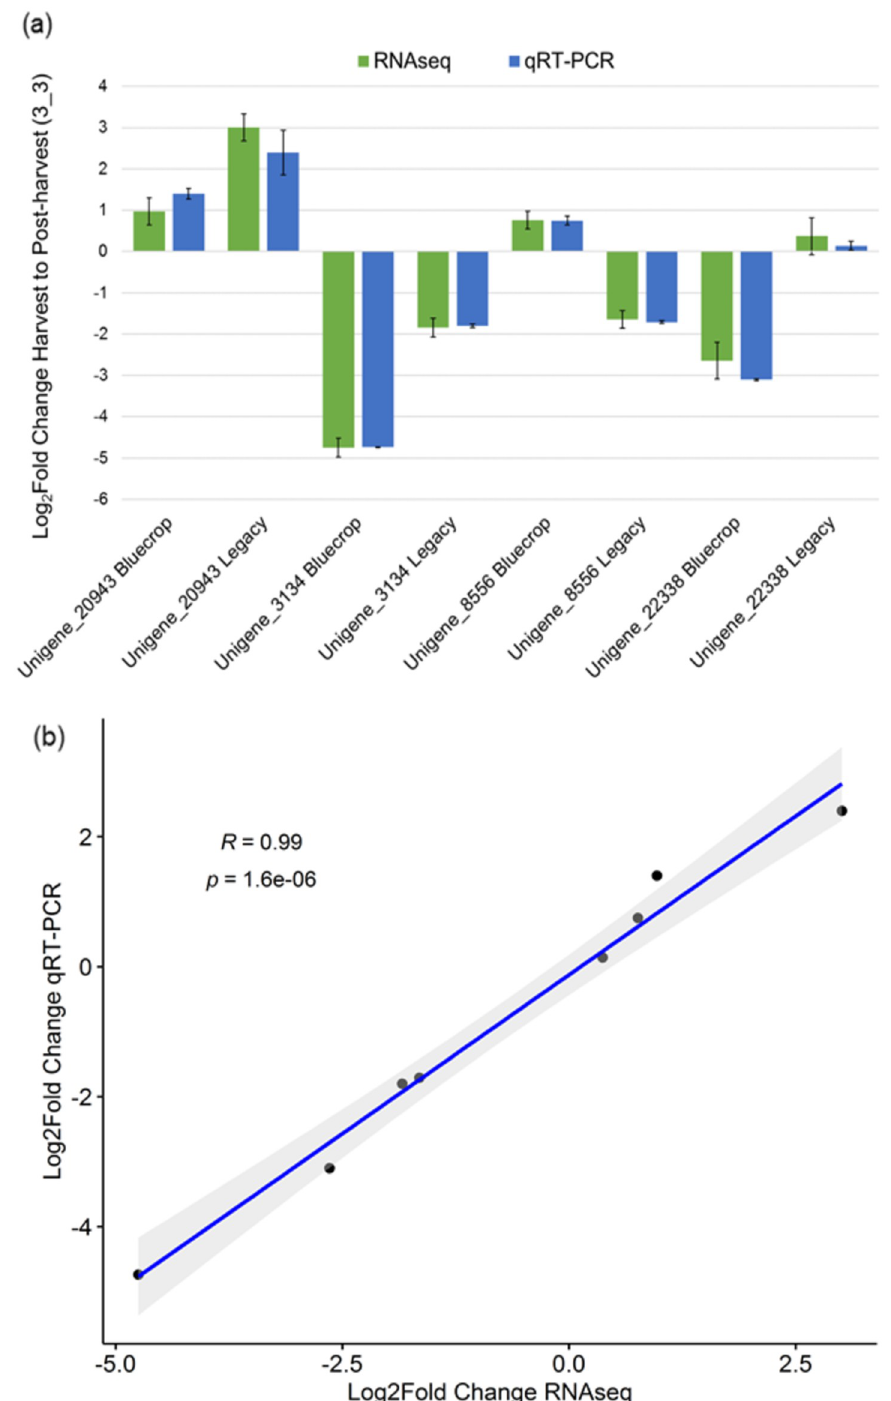
Fig 7. (a) Comparison of the relative expression levels obtained by RNAseq and qRT-PCR for each of the unigenes selected for experimental validation as Log 2 fold-change from harvest (H) to 24 dph (3_3) for each unigene. The x-axis represents each unigene cultivar combination and the y-axis represents the Log 2 fold-change from harvest (H) to 24 dph (3_3). (b) Correlation between RNAseq and qRT-PCR (as log 2 fold change ratio of relative expression at harvest (H) and 24 dph (3_3) in ‘Bluecrop’ and ‘Legacy’) showing the Pearson correlation coefficient and p-values.